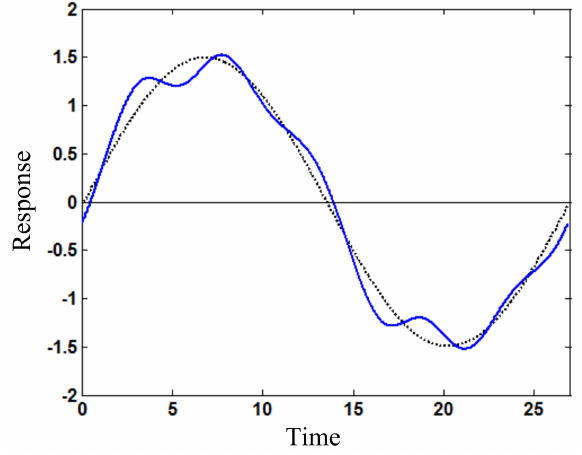
Figure 11. Stationary response ( w ) varying with time ( t ) for loading frequency ω = 0.23 (blue solid line: response based on periodic solution; black dotted line: response based on first harmonic term).